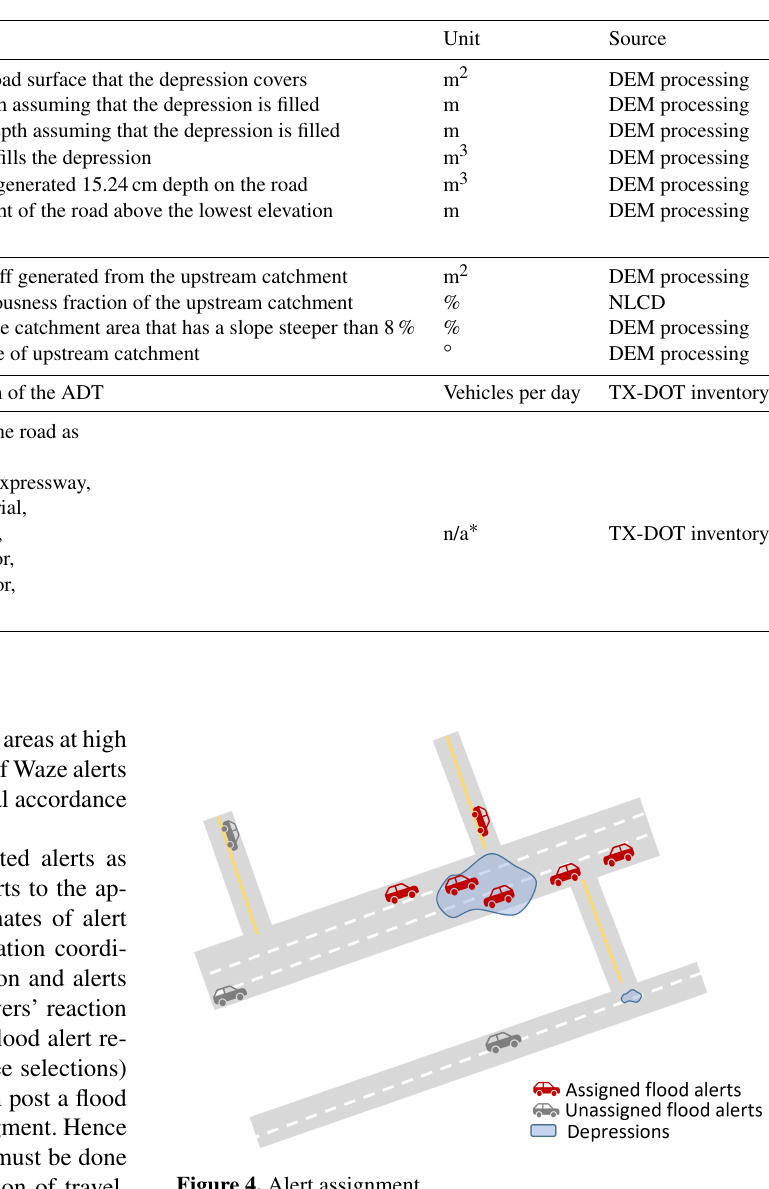
Table 1. Physical depression/catchment descriptors.